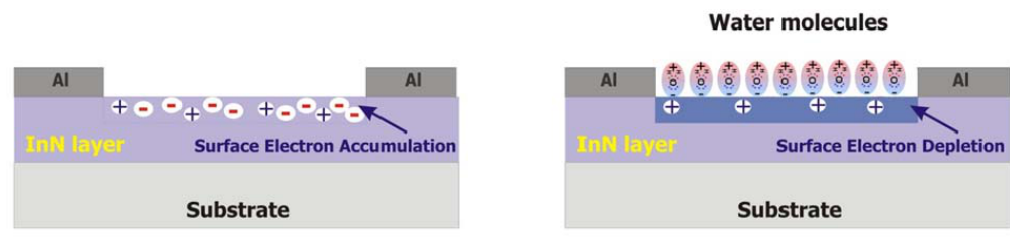
Figure 13. The sensing mechanism of the InN-based water condensation